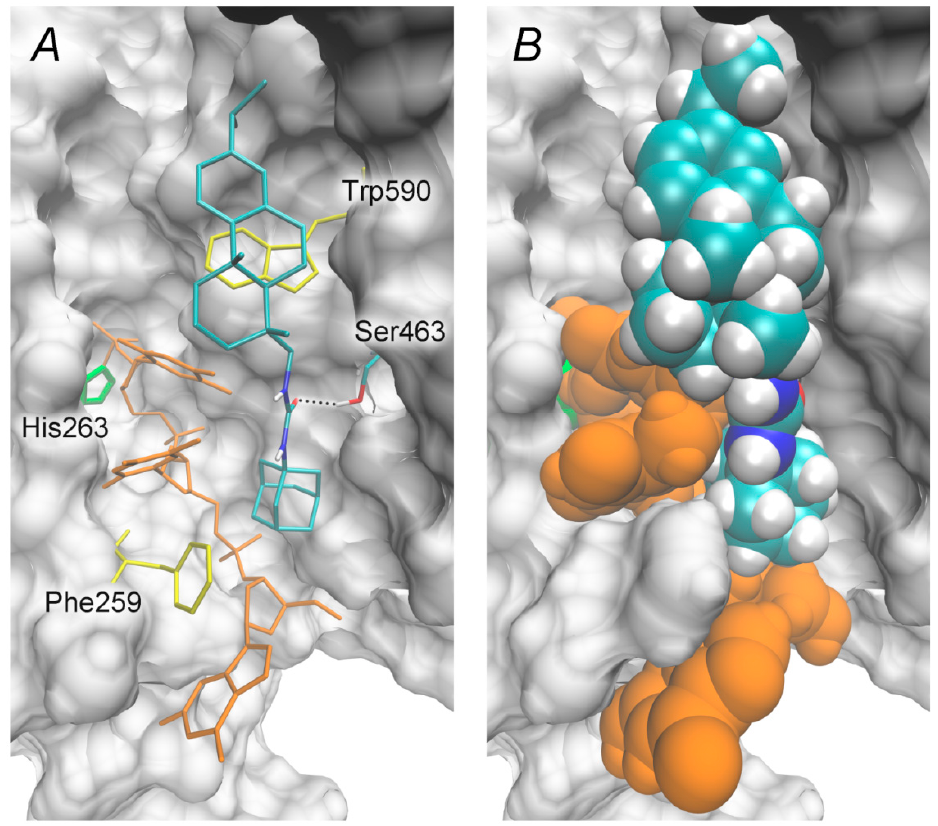
Figure 6. Position of the resin acid derivative 1 in the molecular model of human TDP1 intermediate, Δ G calc = − 9.0 kcal/mol. ( A ) Inhibitor’s interactions with a covalently bound DNA fragment and TDP1 residues. The oligonucleotide is shown in orange, His263 in green, and hydrophobic Phe259 and Trp590 in yellow. The dotted line indicates a hydrogen bond. ( B ) Van der Waal’s representation of the modeled TDP1–inhibitor complex.